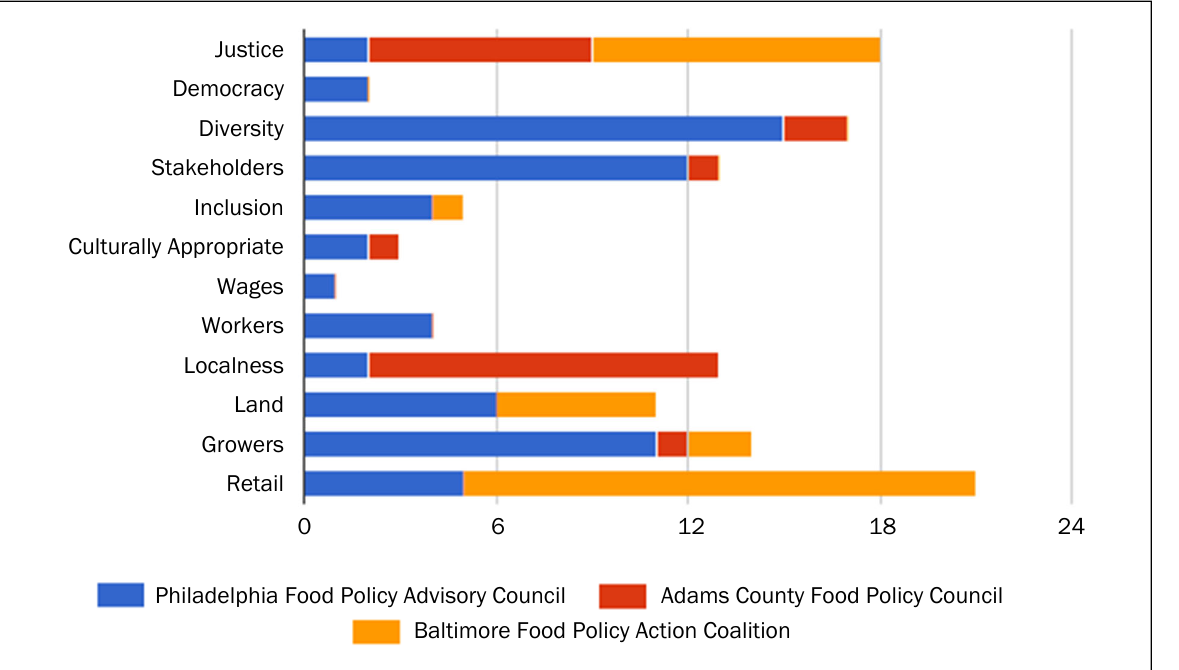
Figure 1. Results from Content Analysis for FPC